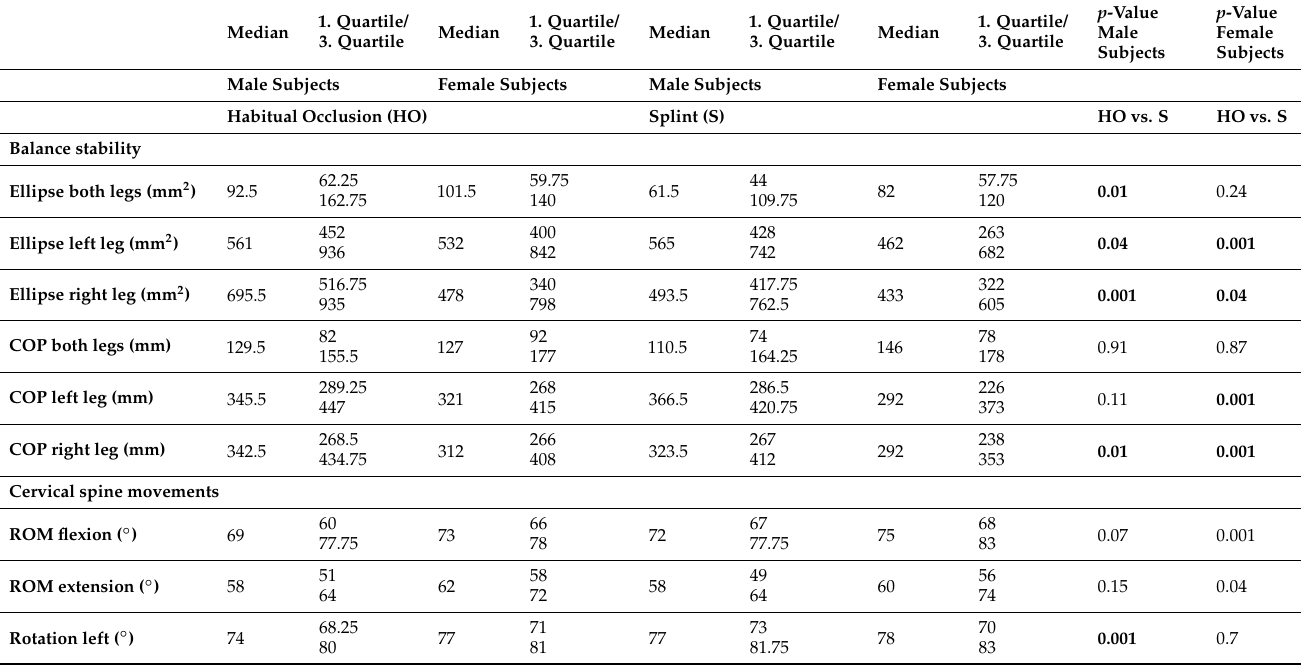
Table 2. Median, 1st and 3rd quartiles of all parameters for men and women. A comparison between the habitual occlusal position (HO) and the splint (S) condition for both men and women. Significant p -values are marked in bold following Bonferroni-Holm